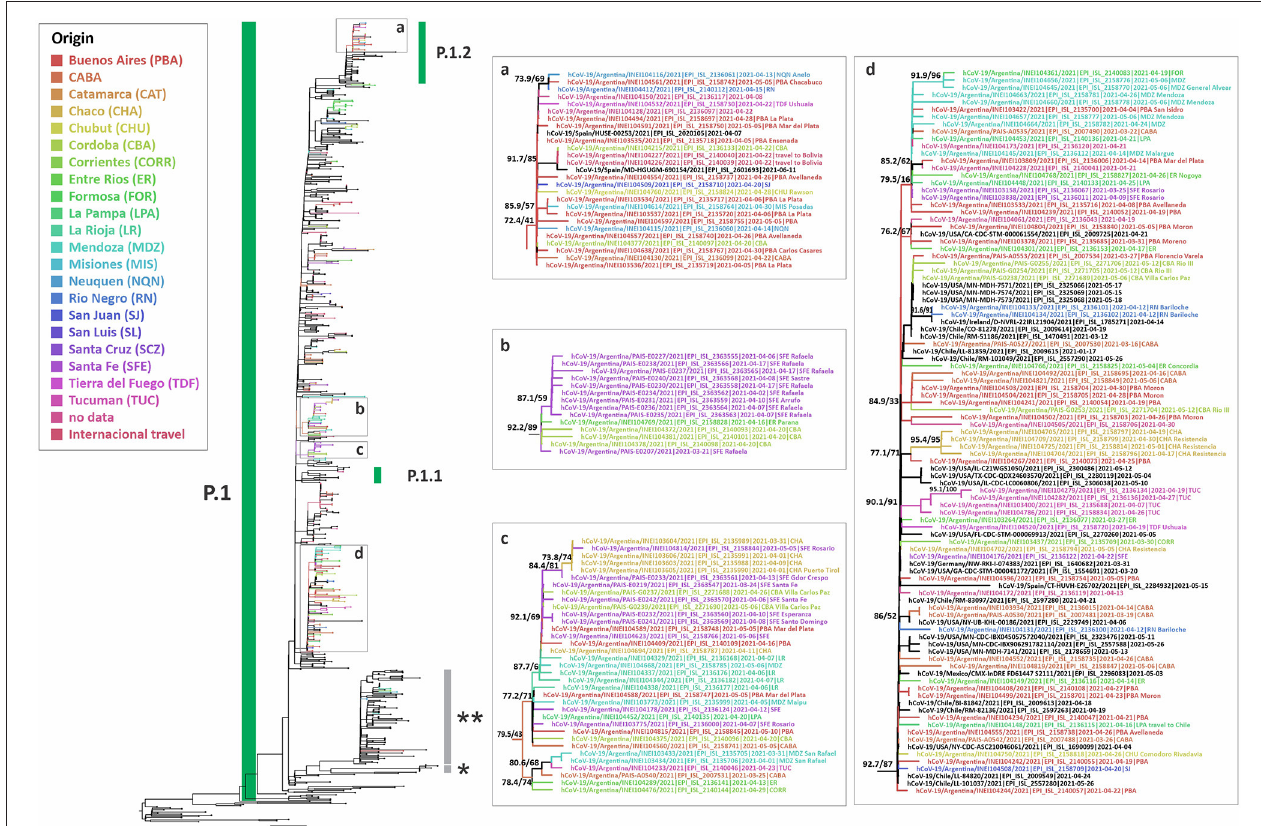
FIGURE 4 | Phylogenetic tree of SARS-CoV-2 whole-genome sequences of Gamma (lineage P.1). B.1.1.28 sequences were used as outgroup. Only selected groups with Argentinean sequences are shown. The SH-like/UFB values for the relevant groups are indicated for some groups. *P.1-like-I and **P.1-like-II described by Gräf et al. (15). UFB, ultrafast bootstrap. The panels (a–d) represent insets of some groups from the tree.